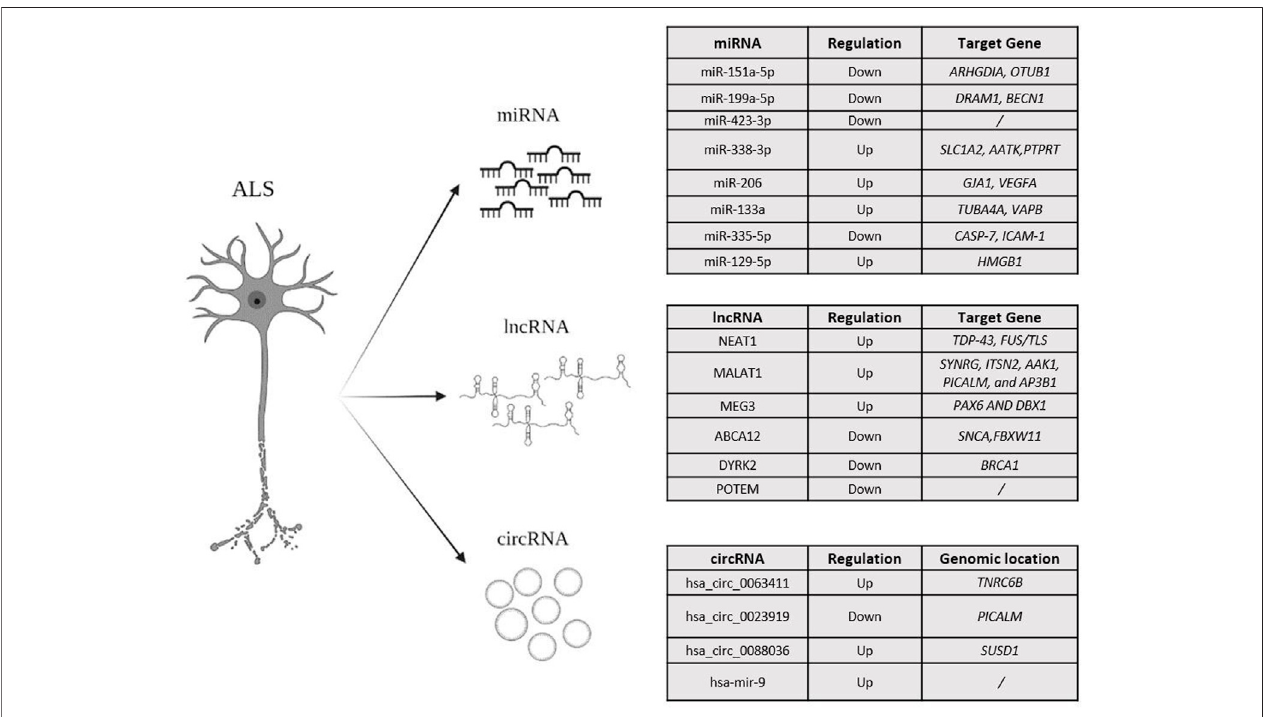
FIGURE 2 | An overview of the miRNA, lncRNA and circRNAs, mainly investigated in ALS.